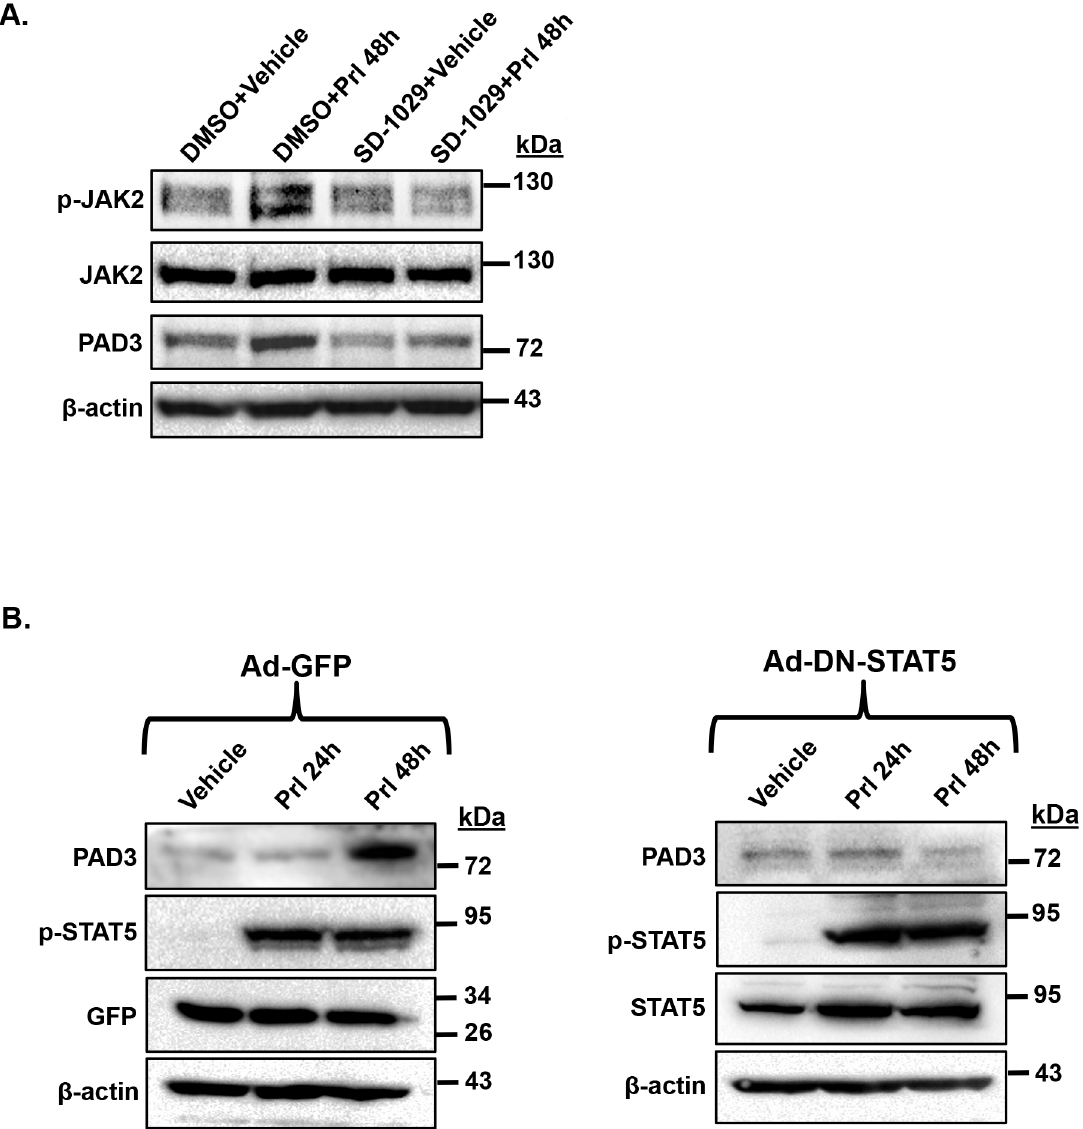
Fig 4. Prolactin stimulates the JAK2/STAT5 signaling pathway to upregulate PAD3 expression in CID-9 cells. (A) JAK2 mediates prolactin induced PAD3 upregulation. CID-9 cells were pre-treated for 4 hours with DMSO or 3 μ M JAK2 inhibitor (SD-1029). Following pre-treatment, cells were stimulated with vehicle or 5 μ g/mL of prolactin for 48 hours. After the first 24 hours, cells received fresh inhibitor. Protein concentrations of cell lysates were determined by BCA assay and equal amounts examined by western blot. Membranes were probed with anti-PAD3, p-JAK2, total JAK2 antibodies or with anti- β -actin as a loading control. (B) STAT5 mediates prolactin induced PAD3 upregulation. CID-9 cells were infected overnight with 10 MOI of an adenovirus expressing GFP (Ad-GFP) or an adenovirus expressing a dominant-negative form of STAT5 (Ad-DN-STAT5) as indicated. The following morning cells were treated with vehicle or 5 μ g/mL of prolactin for 24 or 48 hours. Protein concentrations of cell lysates were determined by BCA assay and equal amounts examined by western blot. Membranes were probed with anti-PAD3, GFP, p-STAT5, total STAT5 or β -actin